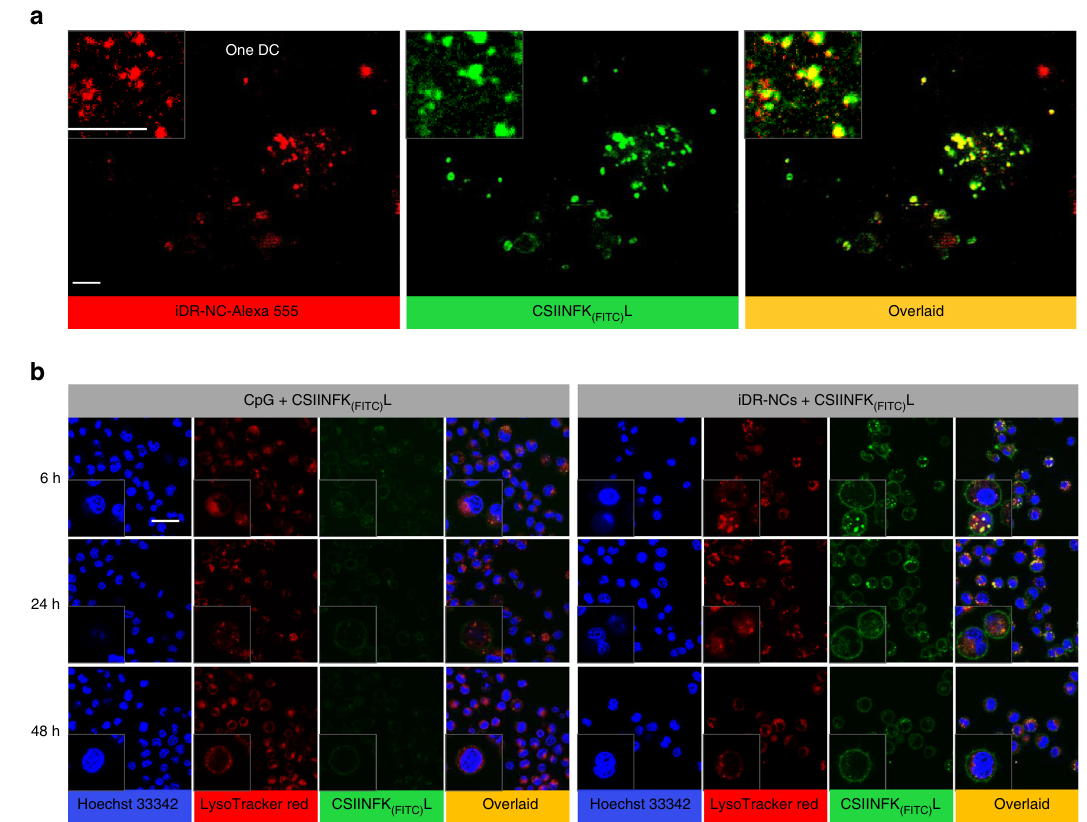
Fig. 4 iDR-NCs induced ef fi cient and sustained antigen presentation. a Instant SIM super-resolution images showing one DC with apparent colocalization between iDR-NC-Alexa 555 and CSIINFEK (FITC) L. Scale bar: 1 µ m. b Confocal microscopy images showing that, relative to CpG, iDR-NCs enhanced the internalization and antigen presentation of CSIINFEK (FITC) L in BMDCs. BMDCs were incubated with iDR-NC/CSIINFEK (FITC) L complexes or CpG + CSIINFEK (FITC) L for 14 h (except for 6-h point), washed, and further incubated for a total of 24 h and 48 h before observation. (CpG: 100 nM